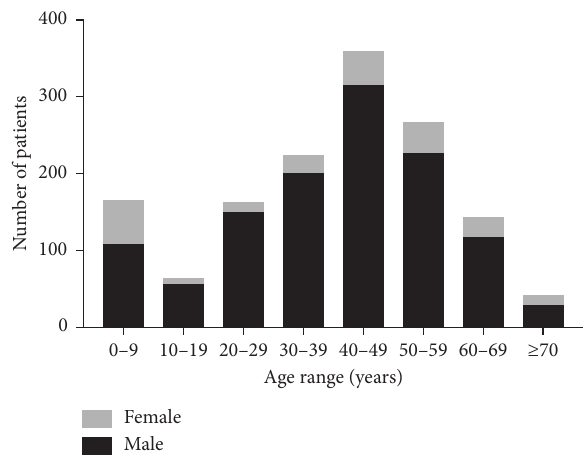
Figure 1: Frequency of ocular trauma by age and gender. Table 1: Characteristics of patients hospitalized for ocular trauma over a 5-year period at the Shandong Eye